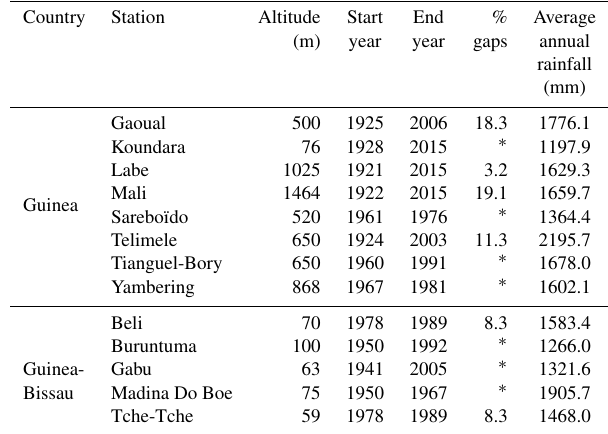
Table 2. List of selected rain gauge for this study. Country Station